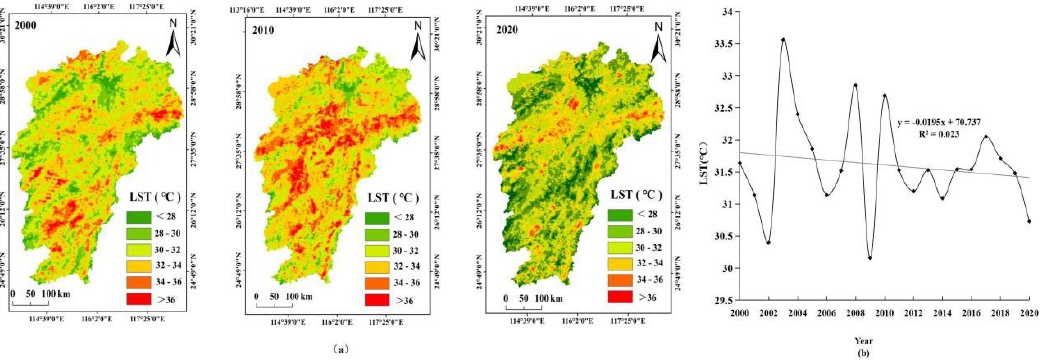
Figure 5. ( a ) The spatial distribution of LST in Jiangxi Province, China during consecutive periods from 2000 to 2020 (represented by the starting year 2000, the middle year 2010, and the last year 2020) and ( b ) the inter-annual variation of its mean value.